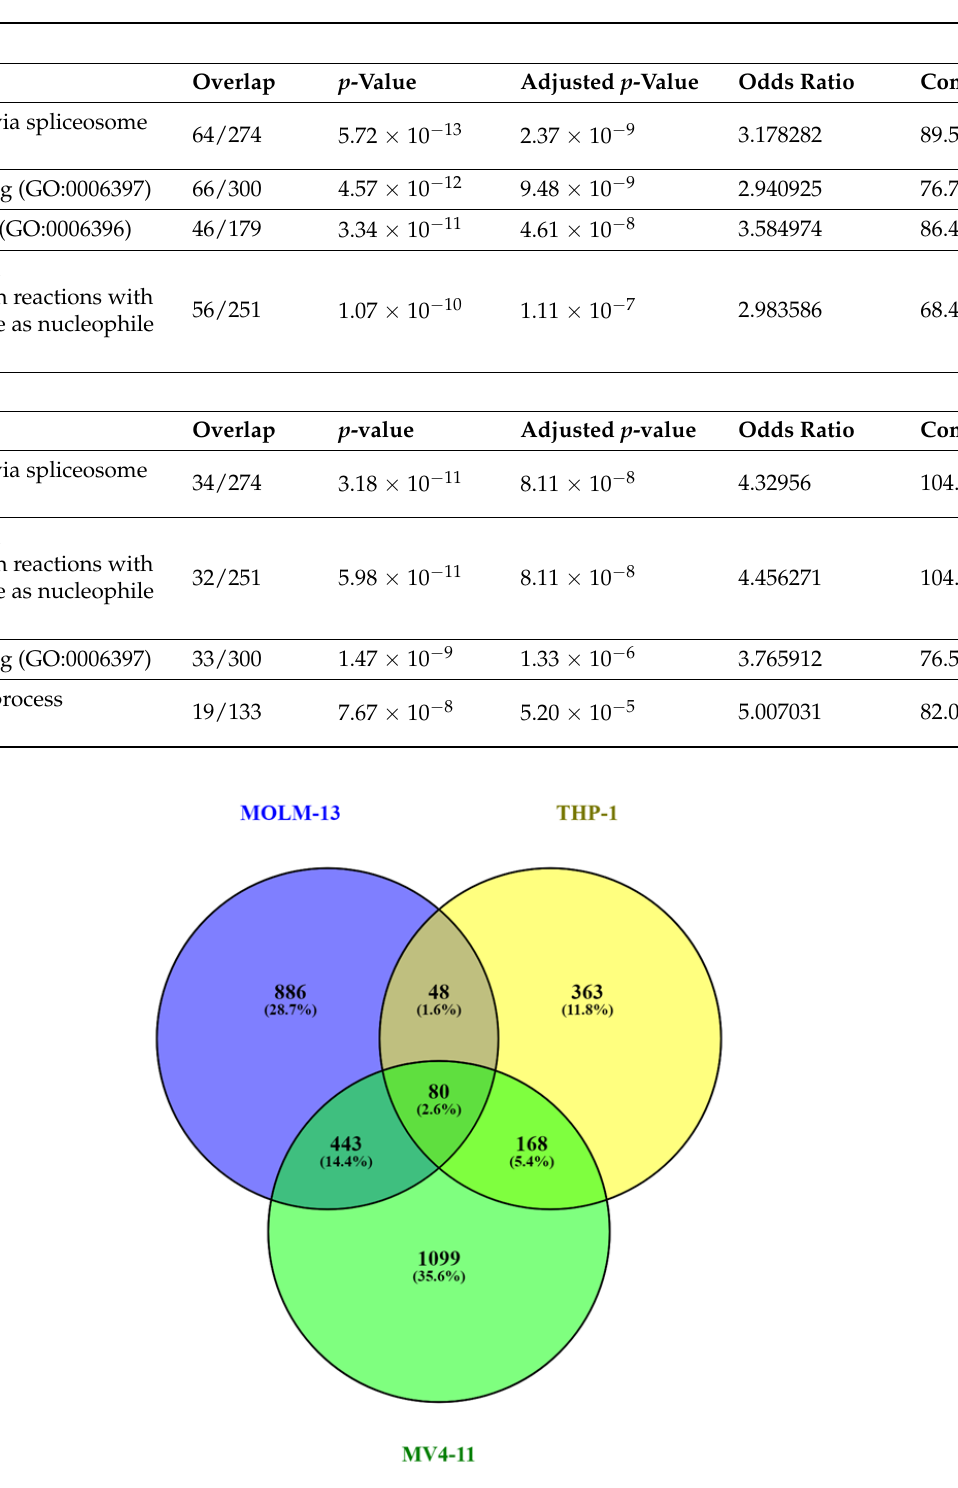
Table 3. GO terms (biological processes) for genes with the broadest H3K79me2 domains in AML cell lines.